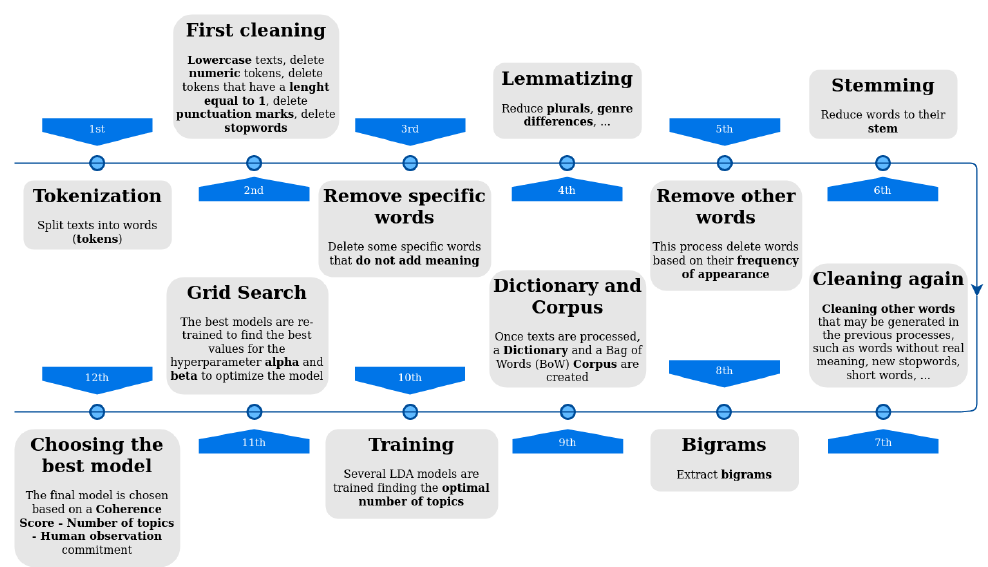
Figure 3. Process pipeline with which each LDA model has been